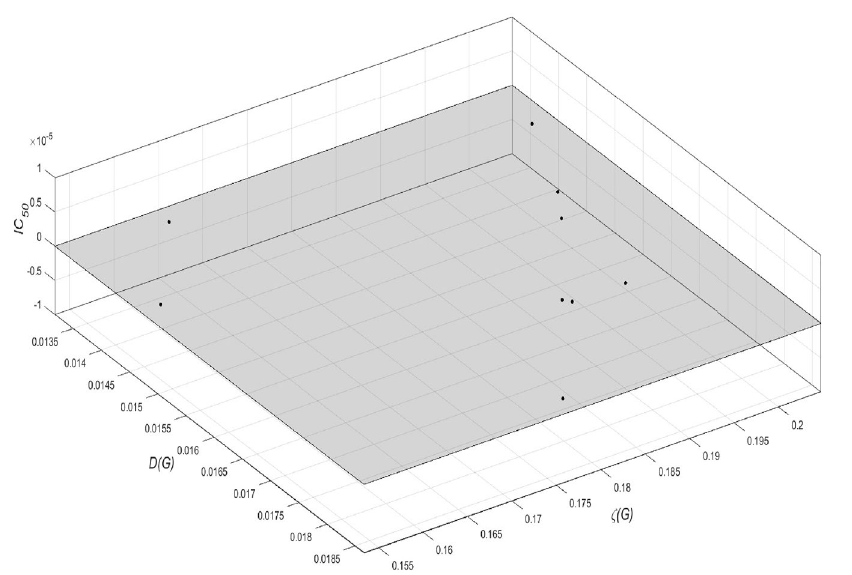
Figure 5. Show the plot of the residuals, where